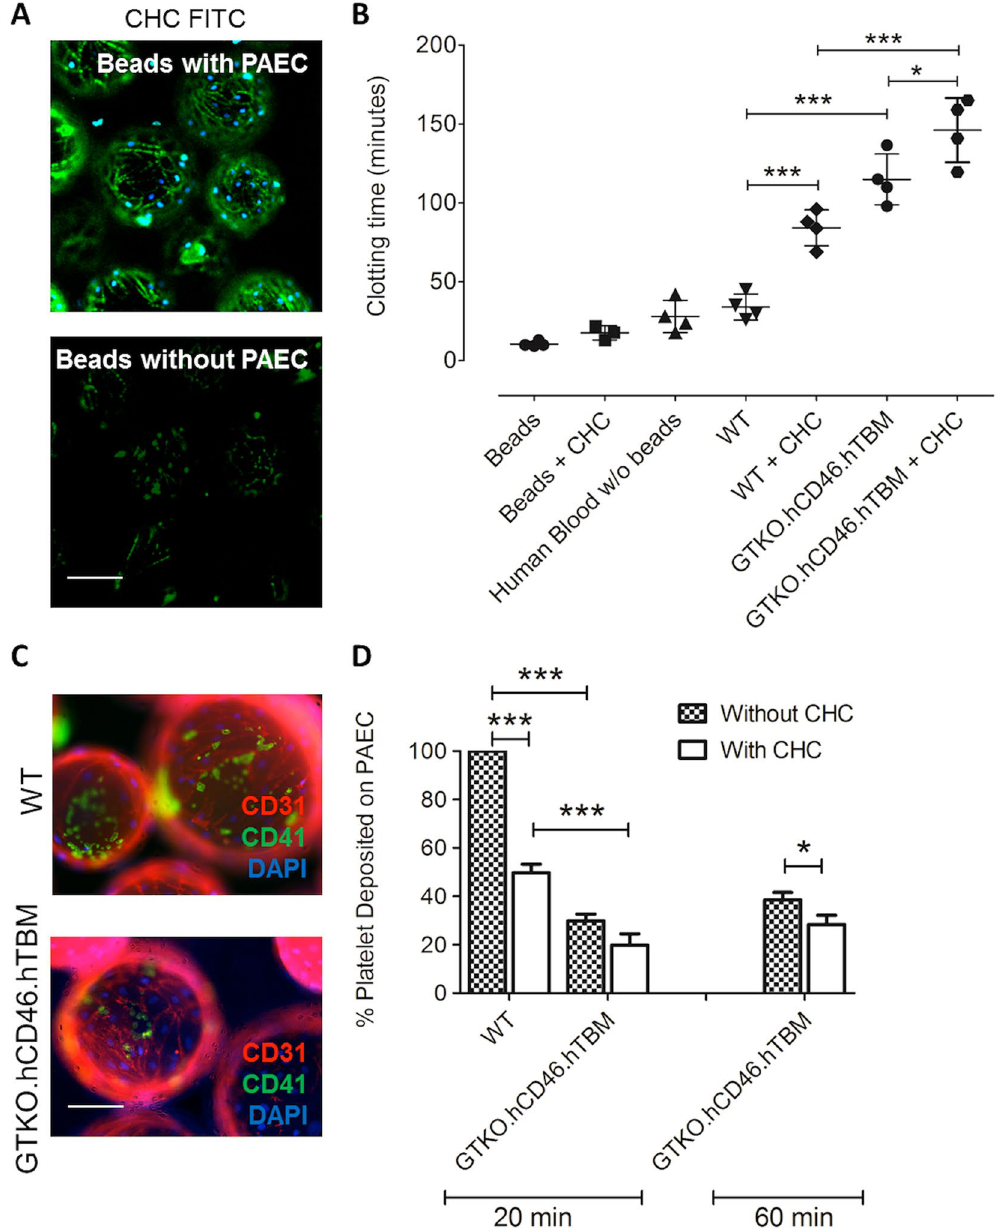
Figure 3. CHC coating of microbead-borne PAEC reduces clotting time of whole human blood. ( A ) Binding of FITC-labeled CHC (100 µ g/ml, 15 min) to PAEC grown on microbeads (top panel), analyzed by confocal microscopy. Minimal binding of FITC-CHC to control beads without PAEC was observed (bottom panel). Nuclei were stained with DAPI. Scale bar: 100 µ m. ( B ) Clotting time of non-anticoagulated whole human blood incubated with and without microbeads. Microbeads carrying GTKO.hCD46.hTBM PAEC significantly prolonged clotting time compared to microbeads carrying WT PAEC. Coating of WT or GTKO.hCD46.hTBM PAEC on microbeads with CHC significantly prolonged clotting time compared to uncoated PAEC. Statistical analysis was carried out by one-way ANOVA with Bonferroni correction ( * p < 0.05, ** p < 0.01, *** p < 0.001). Data are mean ± SD of four independent experiments per group. ( C,D ) CHC coating of microbead-borne PAEC reduces deposition of human platelets during incubation with human blood. ( C ) PAEC-bead samples were collected from the whole blood coagulation assays at 20 min and stained for expression of CD31 (red) and deposition of CD41-positive human platelets (green). Nuclei stained with DAPI (blue). Scale bar: 100 µ m. ( D ) Platelet deposition was determined by counting the number of platelets on 20 randomly selected beads, and is presented as % platelet deposition relative to that observed with uncoated WT PAEC. Coating of WT and GTKO.hCD46.hTBM PAEC with CHC significantly reduced platelet deposition at 20 min and 60 min, respectively. GTKO.hCD46.hTBM PAEC showed significantly reduced platelet deposition compared to WT PAEC irrespective of CHC coating. Data are mean ± SD of at least three independent experiments. Significance was tested using one-way ANOVA with Bonferroni correction ( * p < 0.05, ** p < 0.01, *** p <